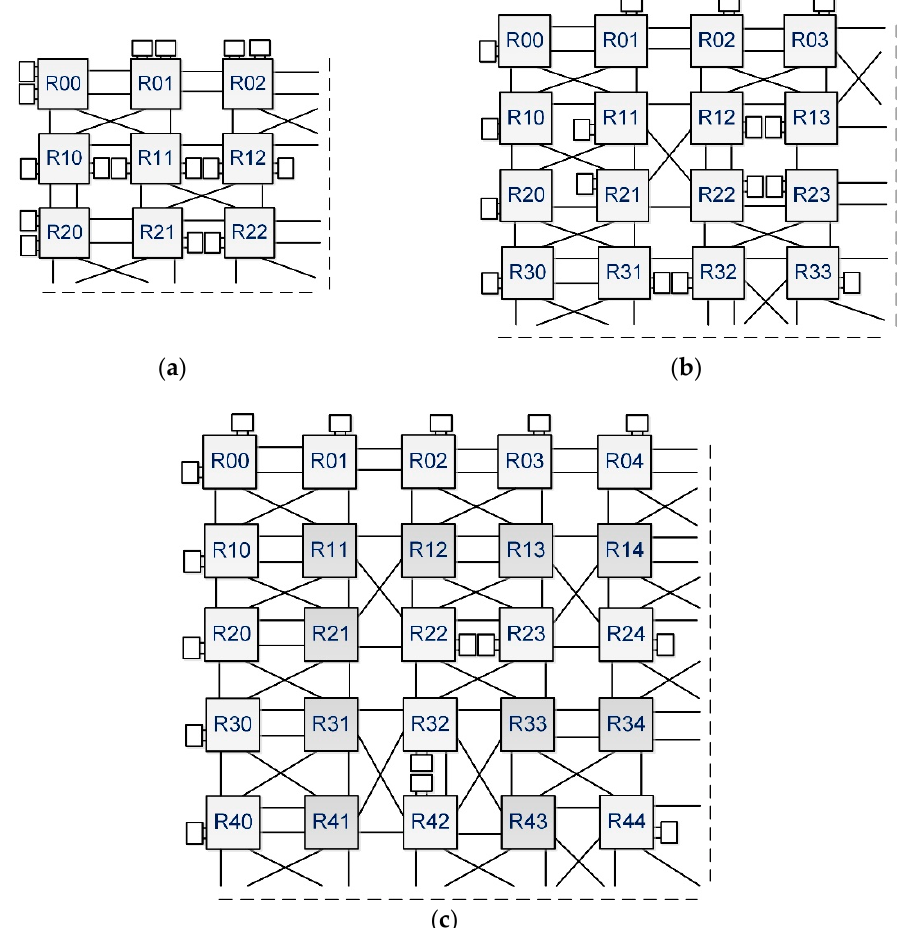
Figure 6. Quadrant view of USNA configurations for simulation ( a ) 6 × 6 network, ( b ) 8 × 8 network, and ( c ) 10 × 10 network (darker router: fully linker-port router).